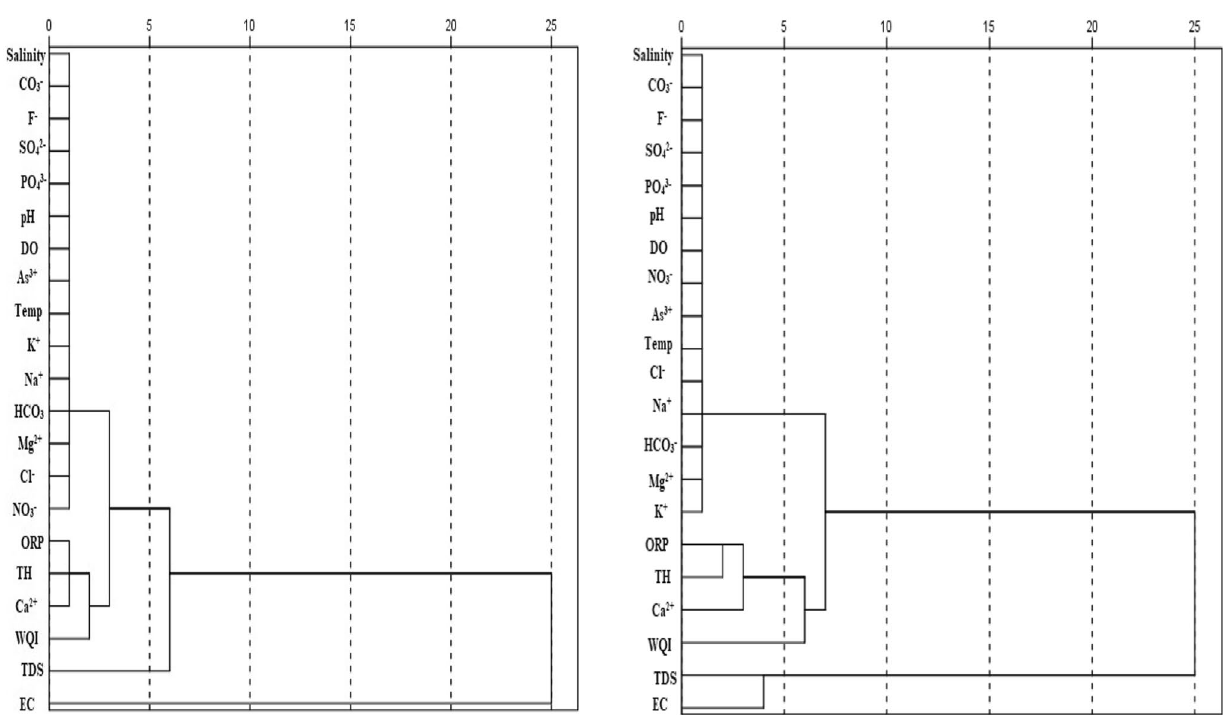
Fig. 7 Dendrogram based on hierarchical cluster analysis shows the similar ground water quality parameters and their contribution to WQI of the study area during a PM and b PoM